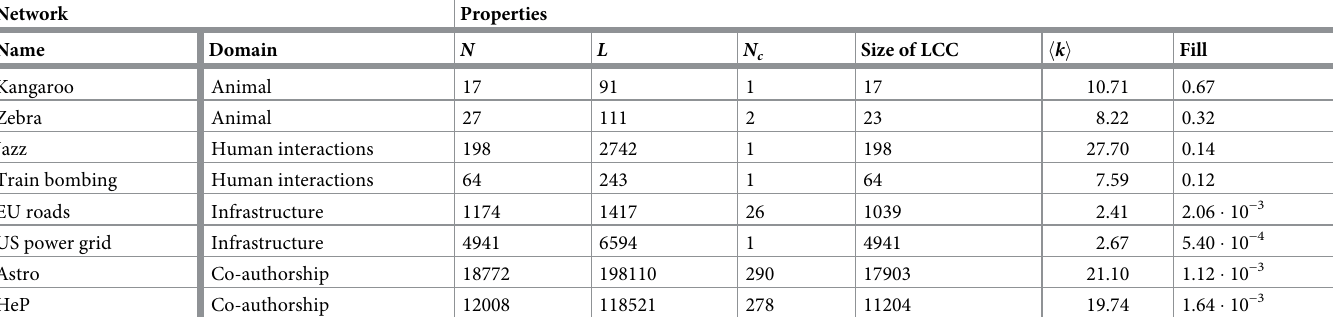
Table 1. Relevant features of the real-world networks of different domains used to develop a similarity criterion based on the method of reconstructed potentials. N , L and N c denote the number of nodes, edges and connected components, respectively; LCC stands for Largest Connected Component; h k i is the average degree of the net- work; the fill is defined as the ratio between the number of edges L and the total number of possible edges ( N ( N − 1)/2 in an undirected network without loops). All data on these networks are available at [46, 47].